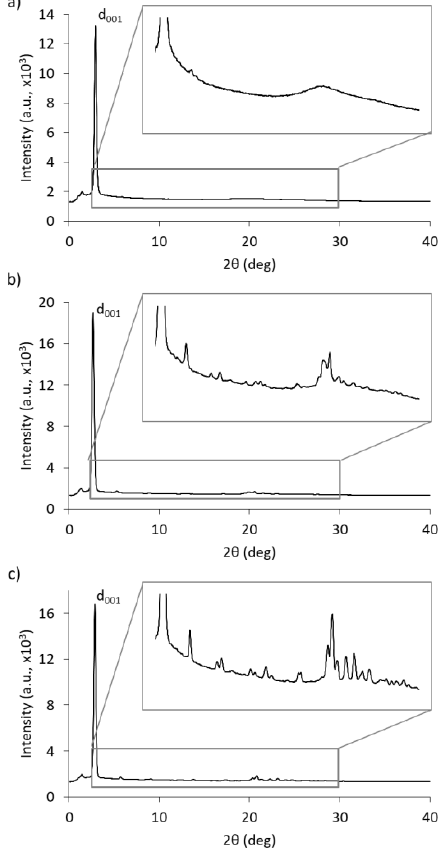
Figure 4. XRD of Th-Thd-Th(10) at 126 °C, in the SmC phase ( a ); at 88 °C, in the CrJ phase ( b ); and at 25 °C, in the crystalline phase ( c ).